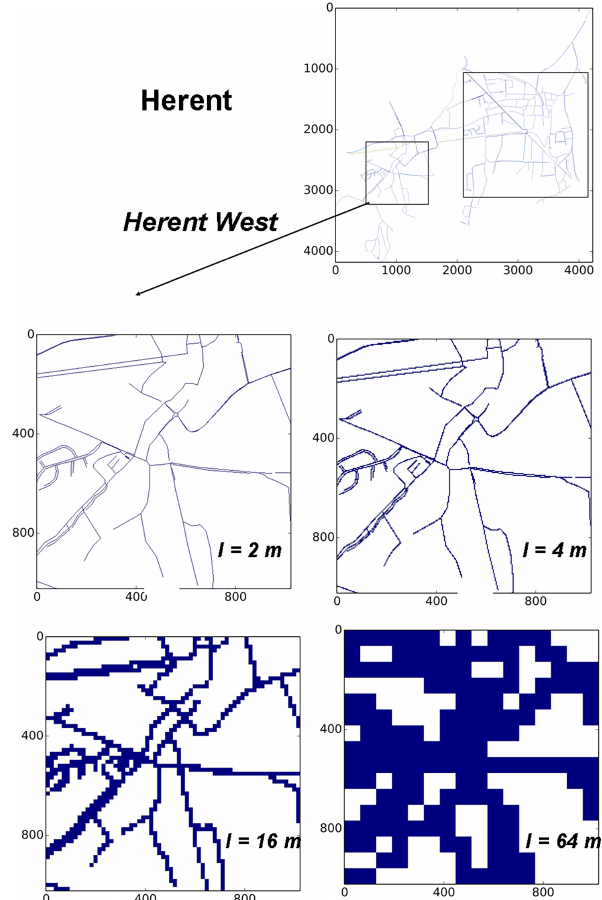
Figure 3. The sewer network of the Herent west study area observed with the help of pixels of various sizes. The axes correspond to me- tres